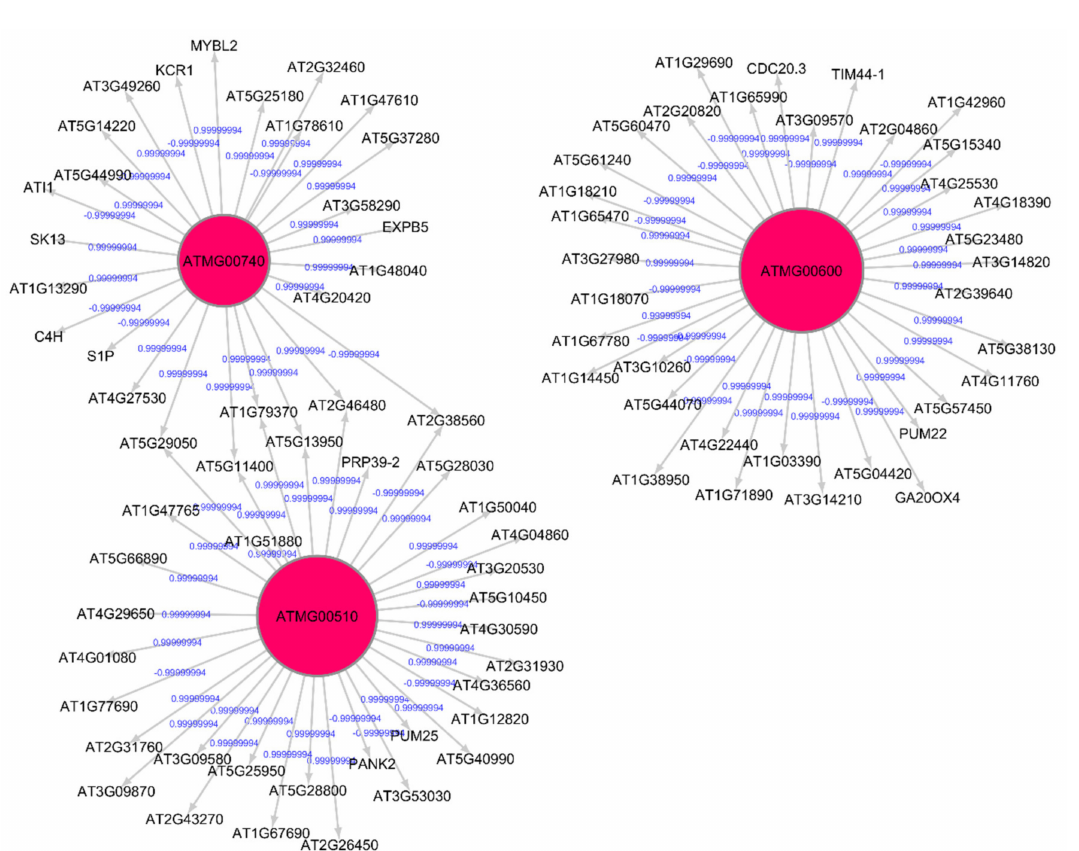
Figure 3. Gene regulatory sub-graph for Arabidopsis thaliana root growth in spaceflight microgravity. The hub genes are the red circles representing the strong interactions with differentially expressed genes. The target (authority) genes are shown without circles. The weights on the arrows are the correlation values between the hub gene and the target